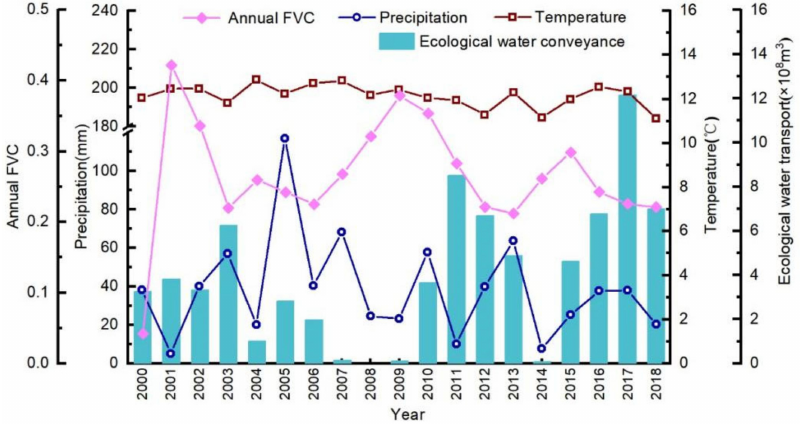
Figure 9. Changes in mean annual FVC, ecologic water conveyance, average annual temperature, and annual precipitation (Ruoqiang station) in the study